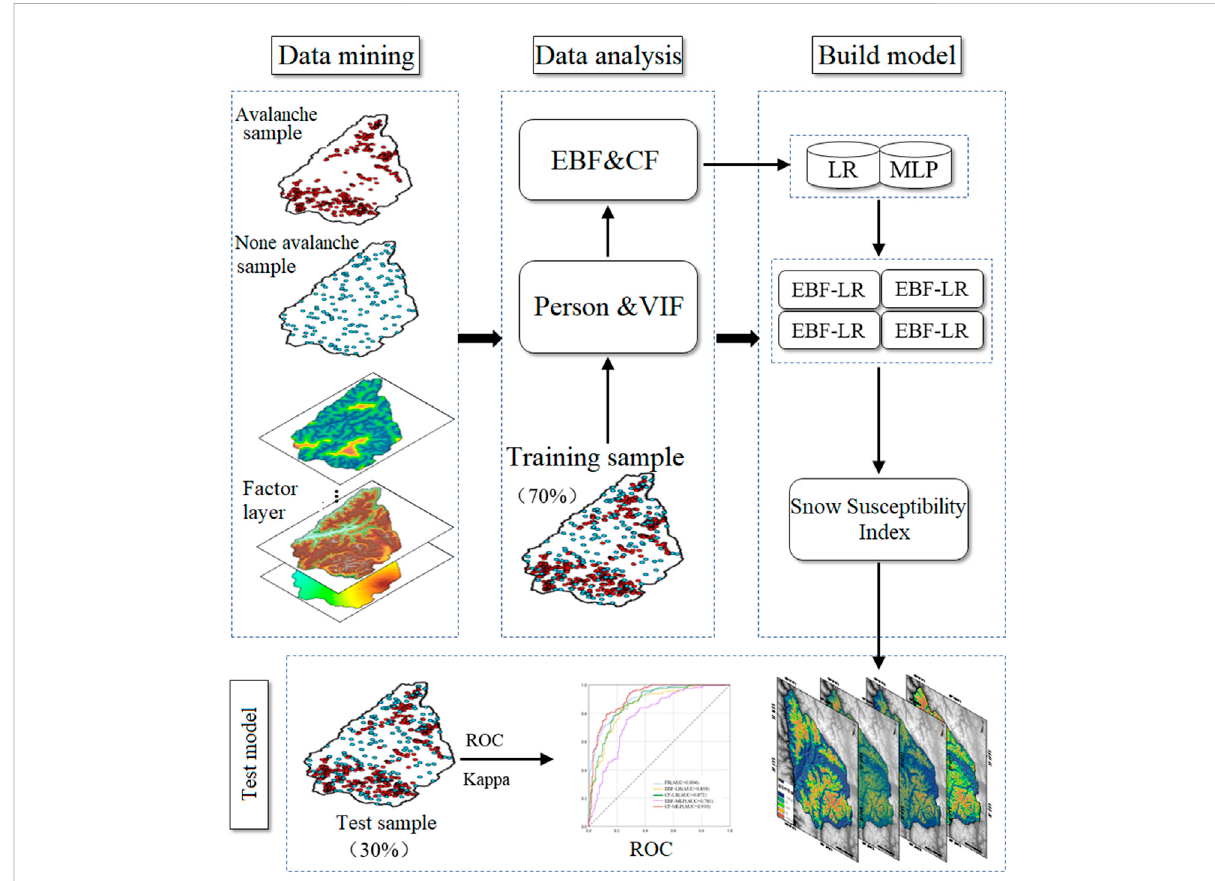
FIGURE 4 Flowchart of the methodology employed for snow avalanche susceptibility